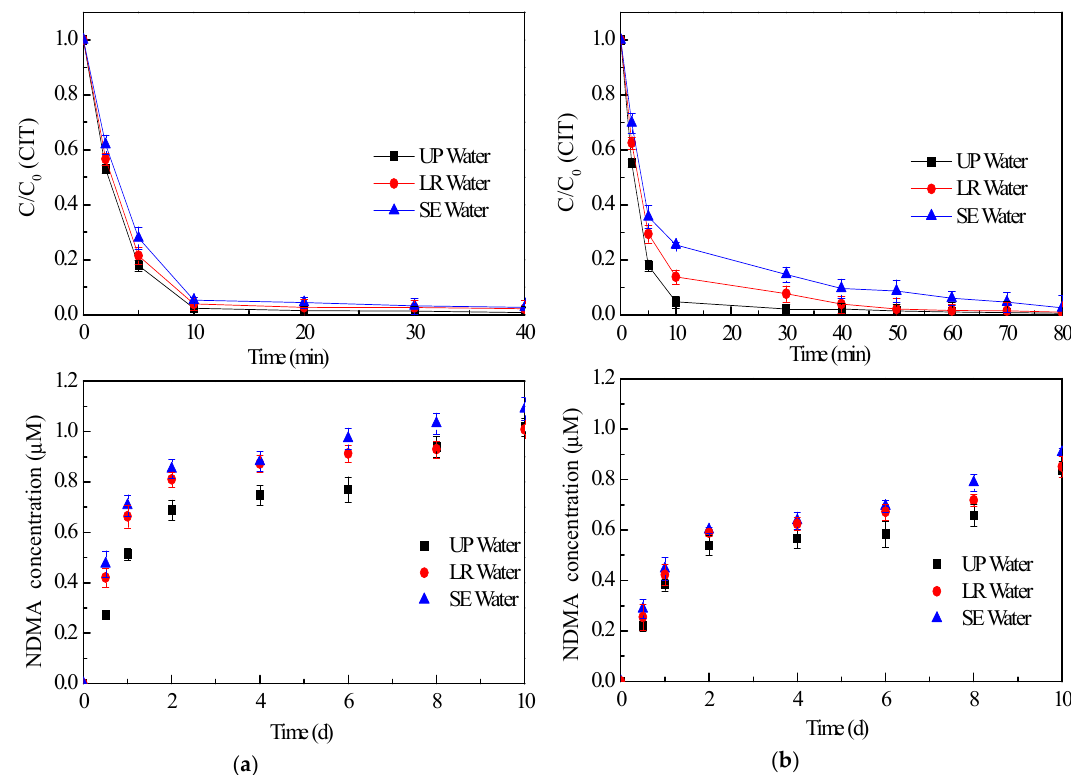
Figure 4. E ff ect of water matrices on CIT removal and NDMA formation (NaOCl ( a ), ClO 2 ( b ), C 0 = 20 µ M, [NaOCl] = [ClO 2 ] = 1